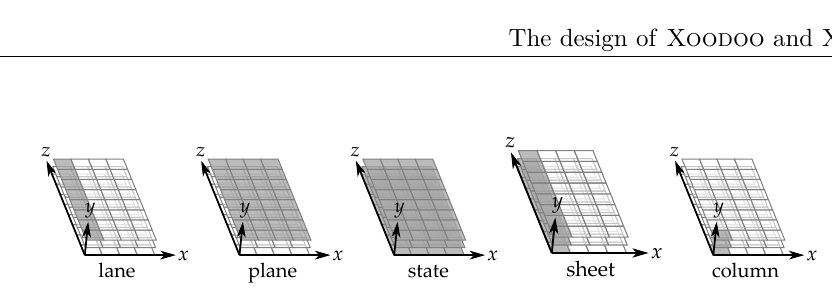
Figure 2: Toy version of the Xoodoo state, with lanes reduced to 8 bits, and different parts of the state highlighted.